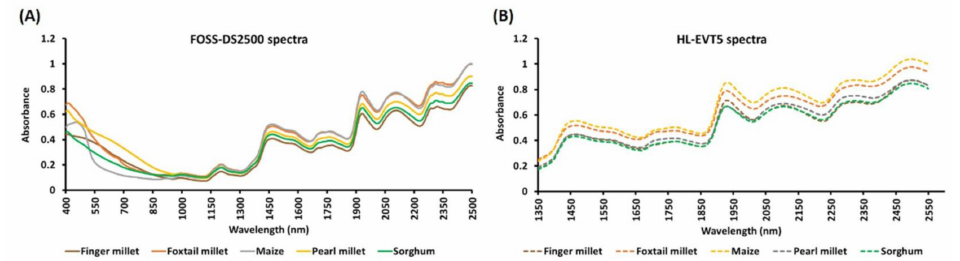
Figure 4. Mean of the near-infrared (NIR) spectra of all grain samples extracted from the benchtop FOSS-DS2500 (400–2498 nm; solid line (–) in grey colour) and the portable HL-EVT5 (1350–2550 nm; dashed line (—) in red colour) instruments.